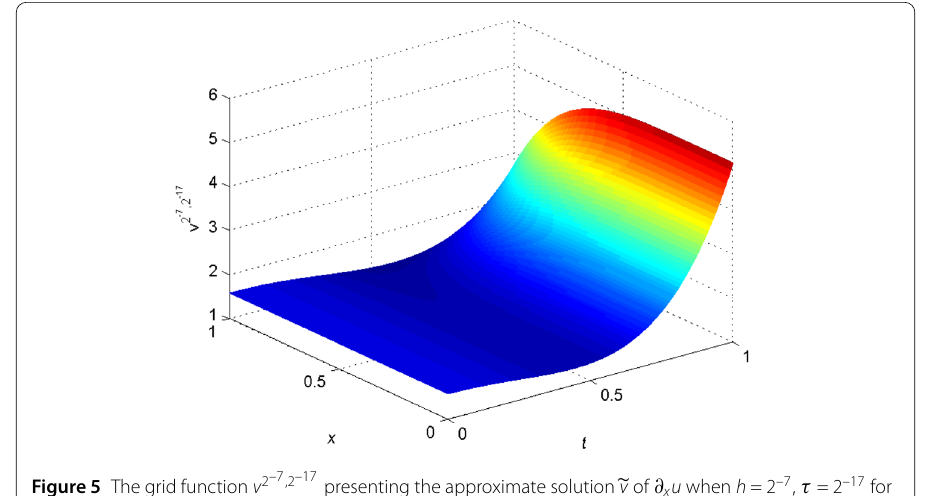
Figure 5 The grid function v 2–7,2–17 presenting the approximate solution (cid:11) v of ∂ x u when h = 2 –7 , τ = 2 –17 for Example 1